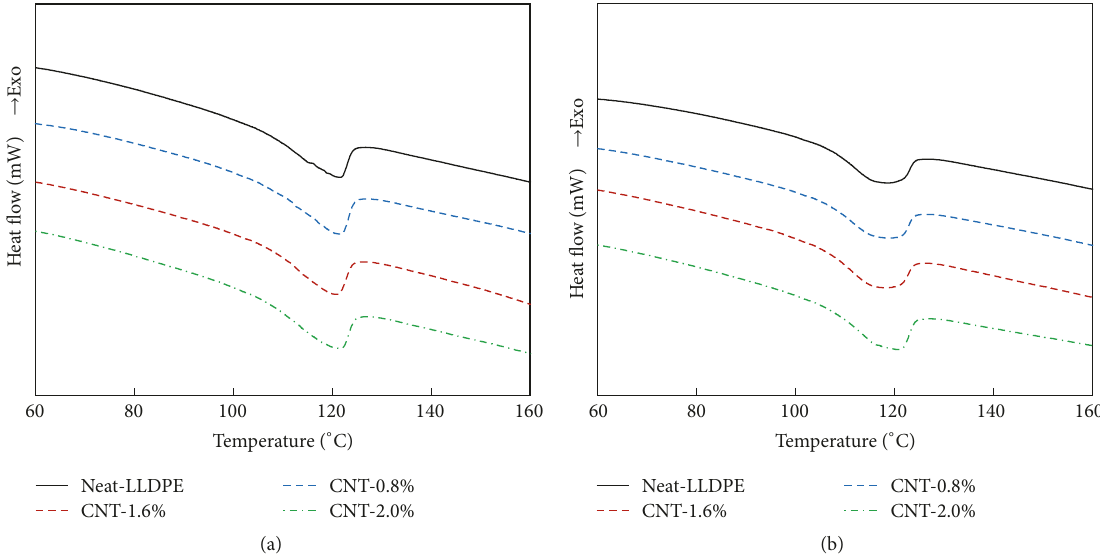
Figure 2: DSC patterns as a function of CNTs content: (a) undrawn and (b) heat drawn LLDPE fibers with a draw rate of 4.